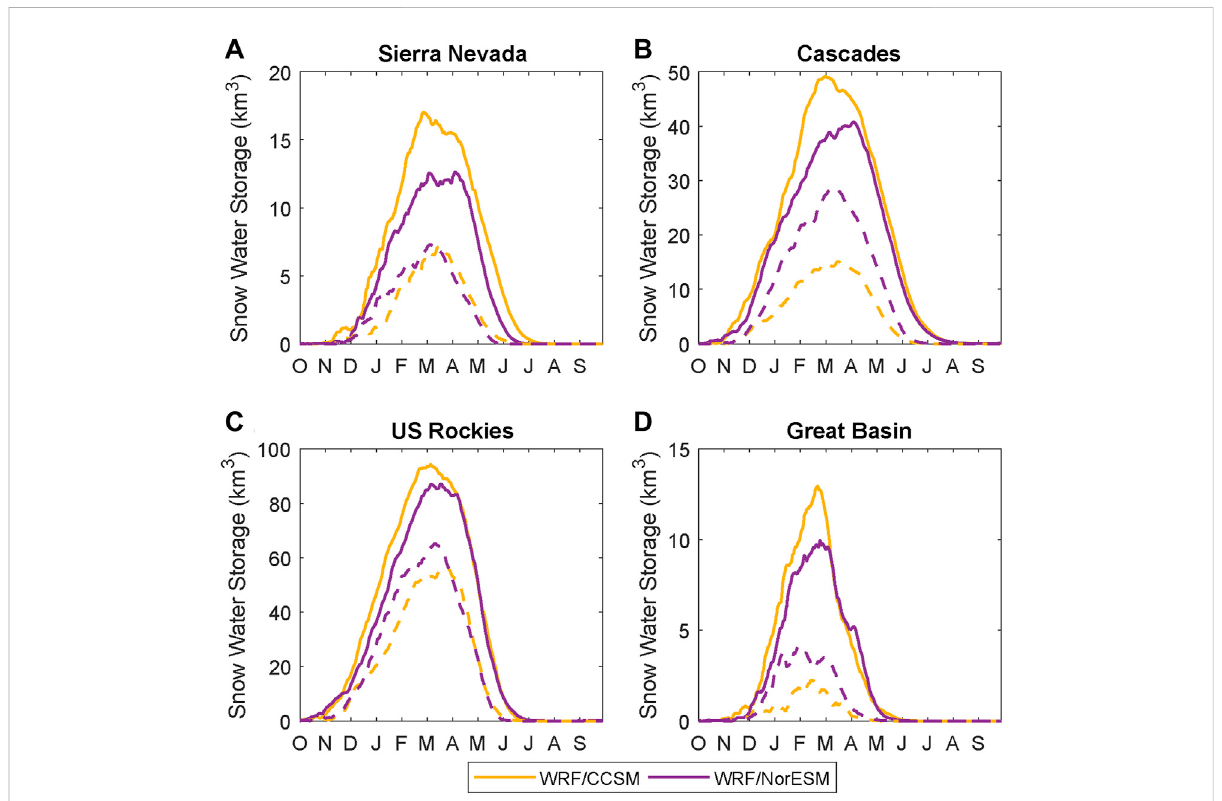
FIGURE 8 Average snow water storage, in km 3 , for each mountain range from the two downscaled GCMs. Solid lines show SWS averaged over the historical decade, and dashed lines show SWS averaged over the end-century decade. (A – D) show the Sierra Nevada, the Cascades, the US Rockies, and the Great Basin,